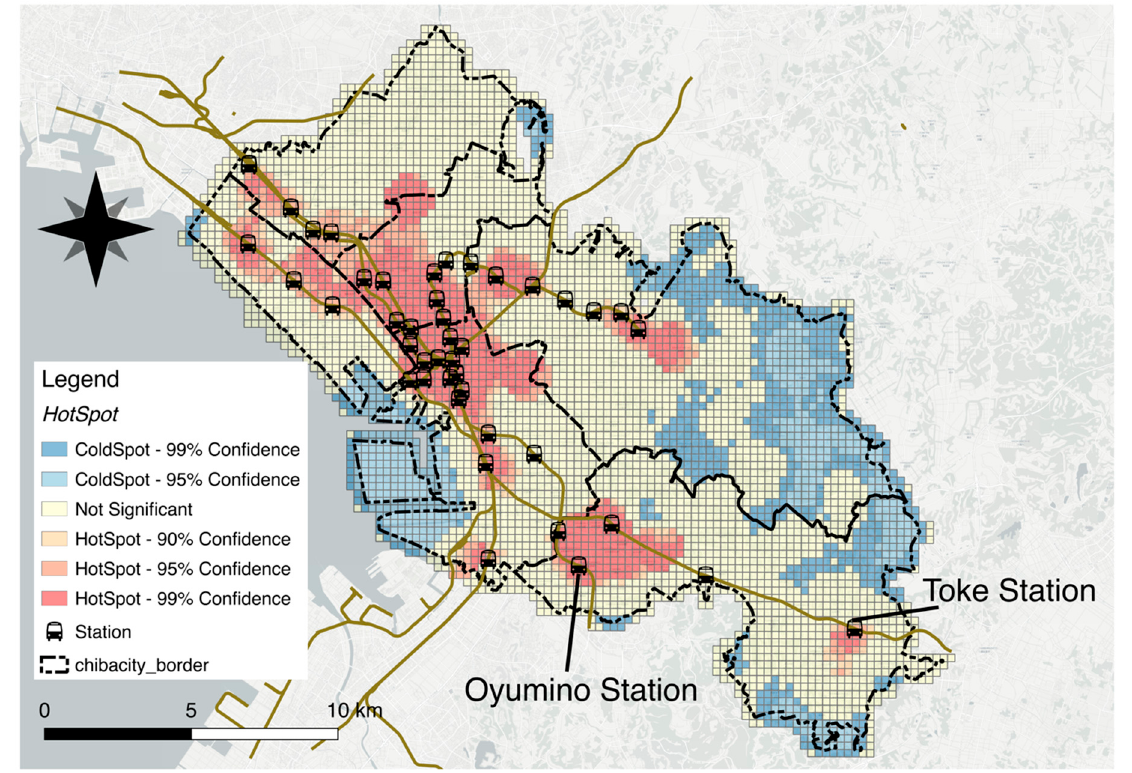
Figure 10. Spatial hotspot analysis (Getis-Ord Gi* method) of reporting positions in 250 m grid